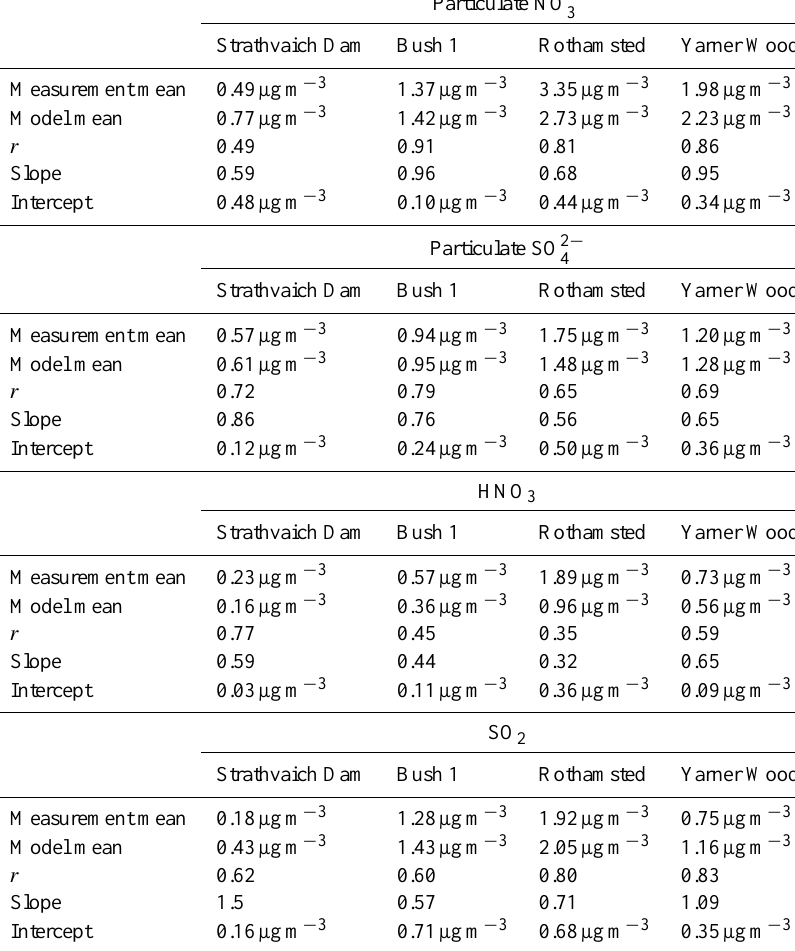
Table 1. Mean concentrations, and correlation and regression statistics, for monthly averaged modelled and measured NO − particulate matter, and HNO 3 and SO 2 gas for the period 2001–2010 at four sites of the AGANet network: Strathvaich Dam (northwest Scotland), Bush 1 (central Scotland), Rothamsted (southeast England), and Yarner Wood (southwest England). The comparison is based on a linear fit where measurement = slope × model +